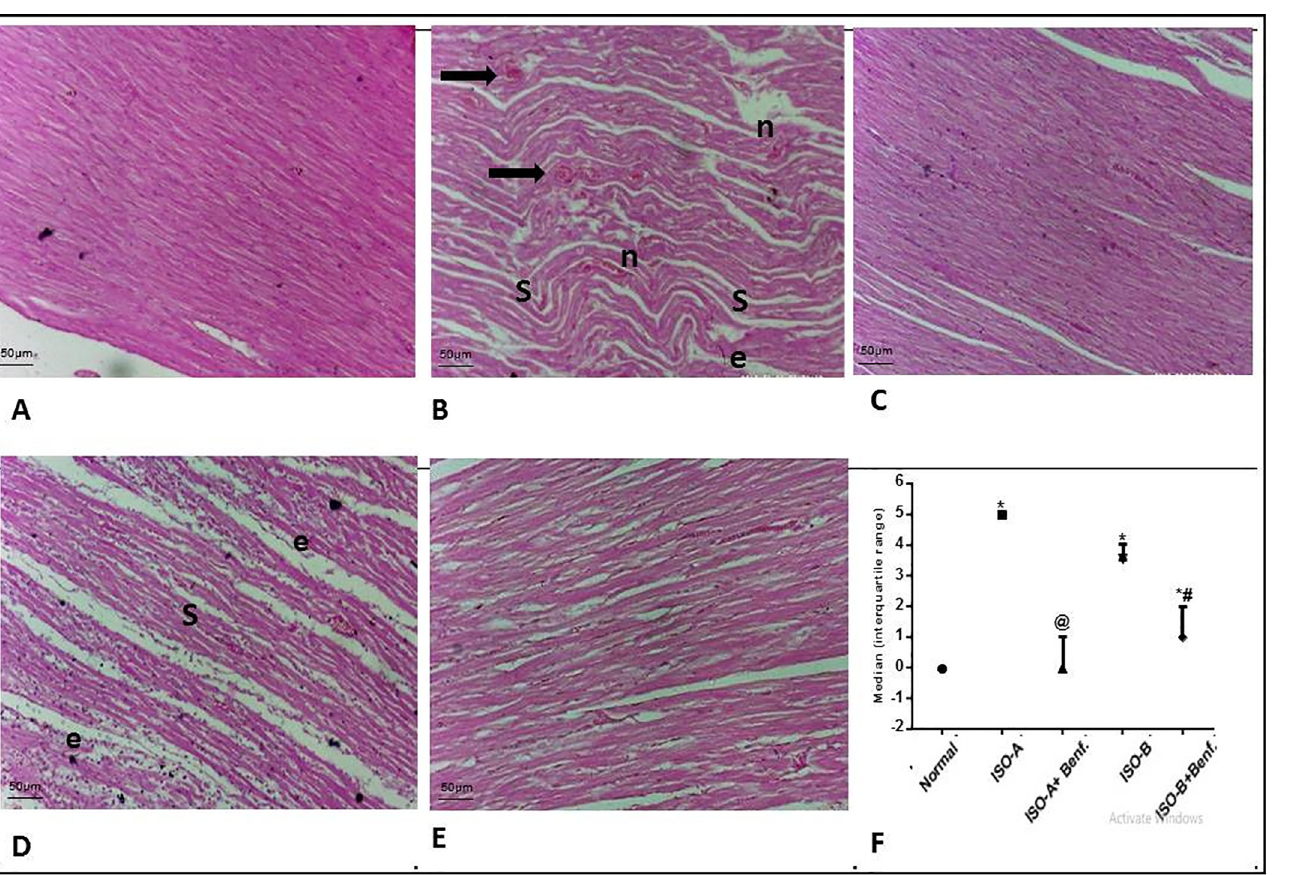
Fig 5. Effect of benfotiamine pre- and post-treatments on histological damage in ISO-induced MI in rats. (A–F) Cardiac specimens were stained with H&E (magnification x200). Normal group (A) showed normal histological structure of cardiac muscle. ISO-A treatment group (B) showed severe cardiac insult with atrophy, muscle shrinkage (s) edema (e) of cardiac muscle, marked inflammatory cells infiltration (n), extensive edema in-between muscle fibers (e), and marked number of apoptotic or degenerated myocytes filament (black arrows). Benfotiamine pre-treatment group (C) showed mostly normal cardiac muscle architecture. ISO-B treatment group (D) revealed shrinkage (s) of cardiac muscle with preserved nuclei all over sections examined, edema in between muscle fibers (e). Benfotiamine post-treatment (E) demonstrated almost normal cardiac muscle with only mild edema in-between muscle fibers. Myocardial score of damage expressed as median (interquartile changes) (F). Each value represents the median value [interquartile range] (n = 6). Statistical analysis was done using non-parametric One-Way ANOVA (Kruskal- Wallis test) followed by Dunn’s multiple comparison test. � p < 0.05 vs. normal, @ p < 0.05 vs. ISO-A, # p < 0.05 vs. ISO-B. ISO-A: ISO pre-treatment control; ISO-B: ISO post-treatment control; ISO-A+ Benf.: benfotiamine prophylactic; ISO-A+ Benf.: benfotiamine treatment.